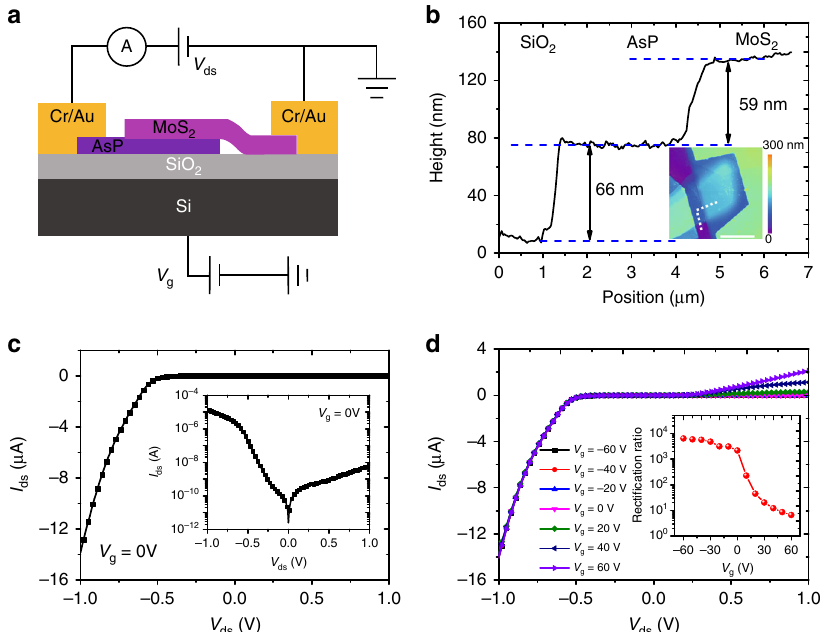
Fig. 1 Electrical characterizations of the MoS 2 /AsP vdWHs device. a Schematic of the fabricated MoS 2 /AsP vdWHs device for electrical measurement. b Line scan pro fi le of the heterostructure from the AFM image shown in the inset. Scale bar is 5 μ m. c I ds – V ds curve of the MoS 2 /AsP vdWHs device at gate voltage V g = 0 V. The inset is the I ds – V ds curve in semi-logarithmic scale. d I ds – V ds curves of the MoS 2 /AsP vdWHs device at different gate voltages varying from − 60 to 60 V. The inset is the gate-dependent recti fi cation ratios of the MoS 2 /AsP vdWHs